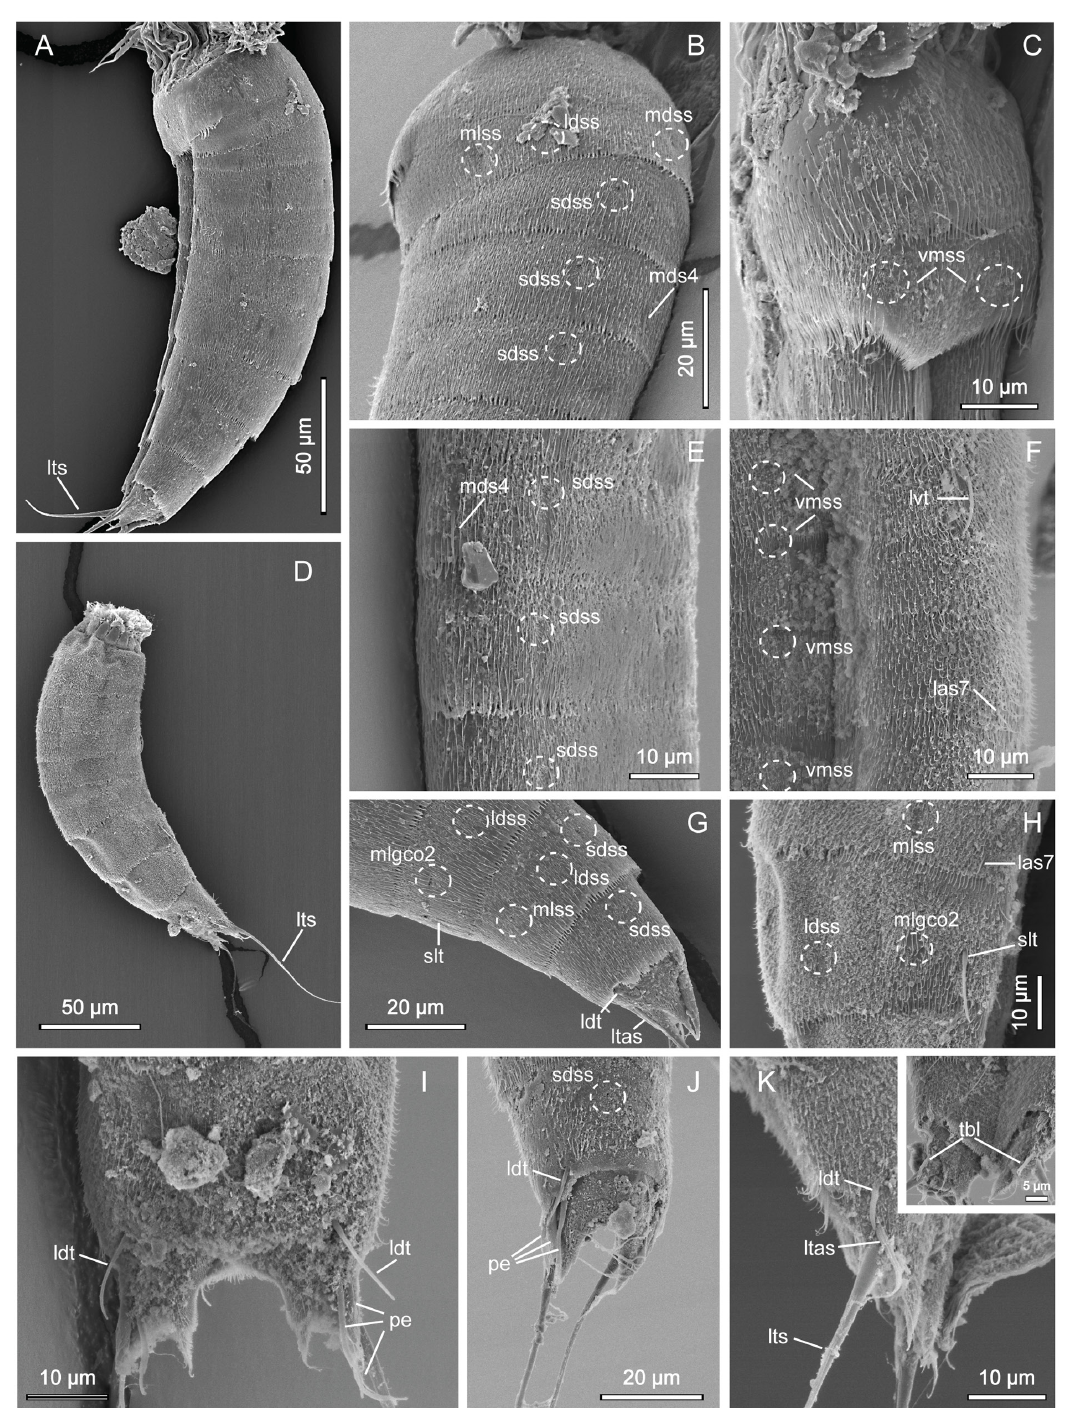
Fig. 4. Scanning electron micrographs showing overviews and details of Echinoderes blazeji sp. nov. A . Dorsolateral overview of female. B . Segments 1 to 4, dorsolateral view. C . Segments 1 to 3, ventral view. D . Lateral overview of male. E . Segments 4 to 6, dorsal view. F . Segments 5 to 7, ventral view. G . Segments 8 to 11 of female, laterodorsal view. H . Segments 7 to 8, lateral view. I . Segments 10 to 11 of male, dorsal view. J . Segments 10 to 11 of male, dorsolateral view. K . Segments 10 to 11 of female, lateral view, with close-up of segment 11 ventral side showing ventrolateral tubules. Abbreviations: see Material